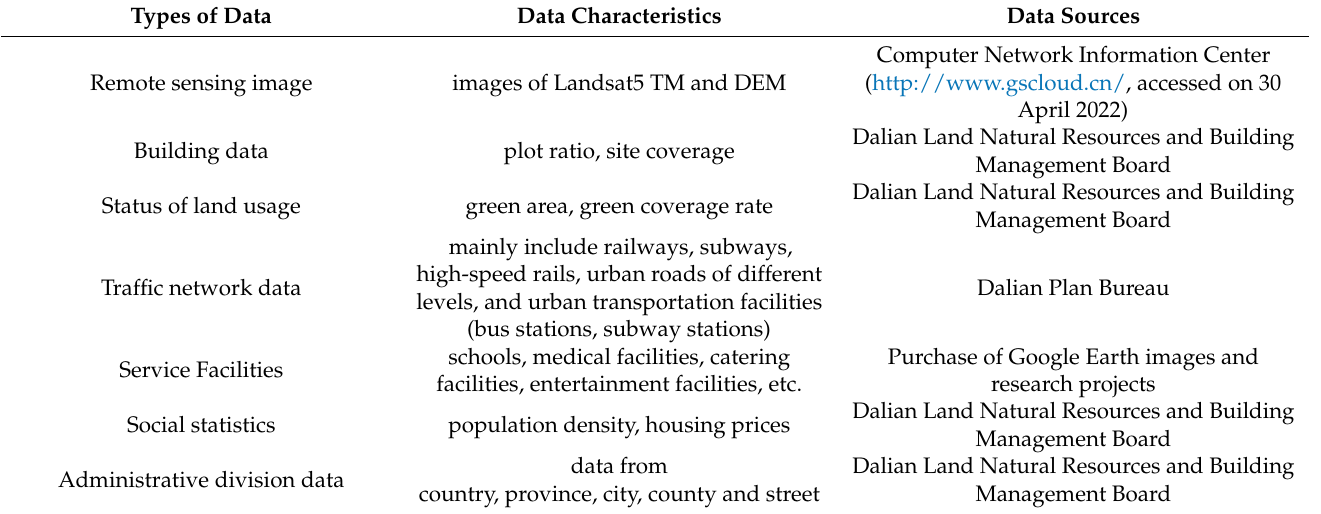
Table 1. Data Description and Sources.